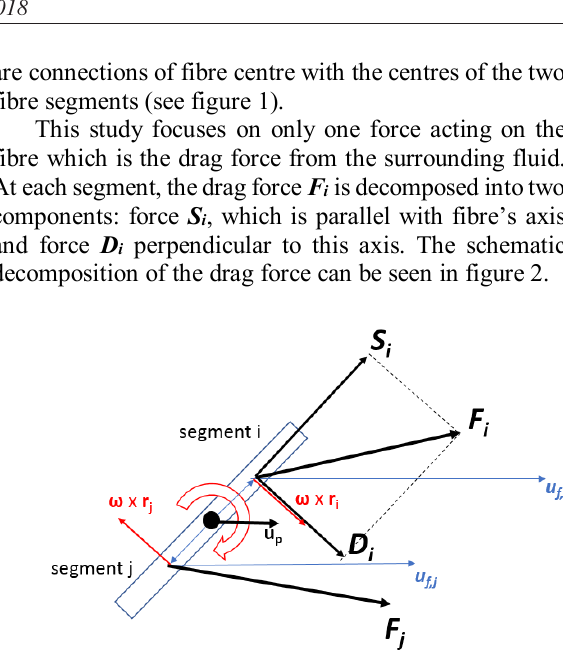
Fig. 2. Forces acting on a fibre during its movement in the fluid The relative velocity of the fibre to the velocity of the surrounding fluid is required for the evaluation of force components S i and D i . The velocity of the segment i is the sum of fibre translation velocity u p and the contribution from rotation 𝝎 × 𝒓 , where 𝝎 is angular 𝑖 velocity of the fibre around its centre. Inclusion of the term 𝝎 × 𝒓 is the major difference compared to the 𝑖 approach of Lo Iacono et al (2005). The effect of this term will be discussed later in this paper. The relative velocity of a fibre is given